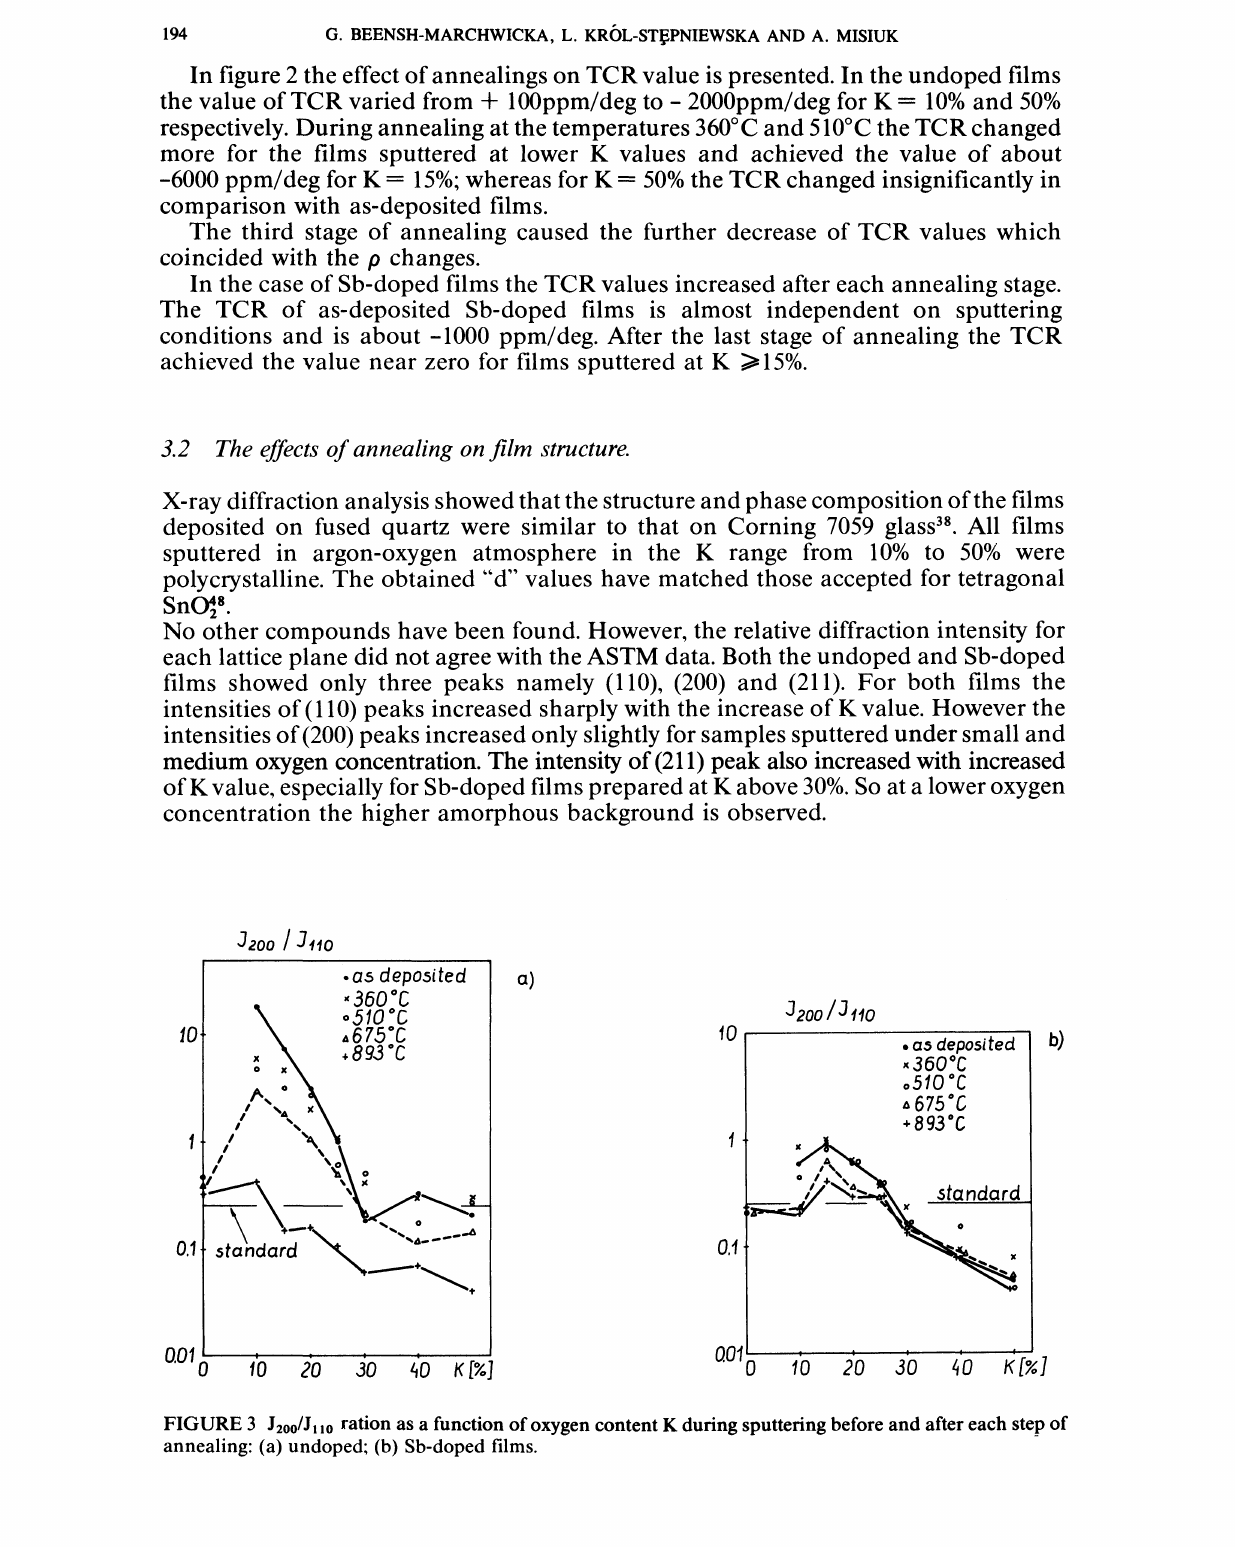
FIGURE 3 J2oo/Jt to ration as a function of oxygen content K during sputtering before and after each step of annealing: (a) undoped; (b) Sb-doped